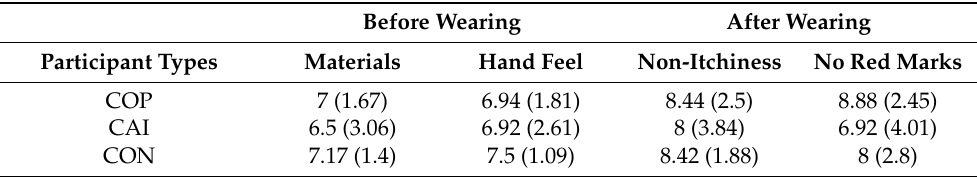
Table 2. Means scores of sensory/tactile comforts based on participant